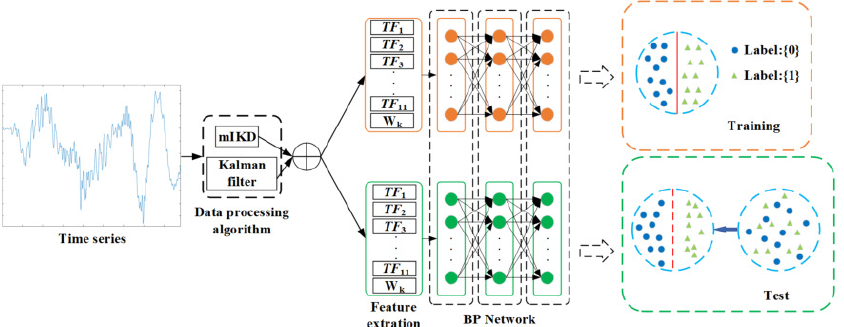
Figure 7. Prediction model of defecation based on BP neural network and bowel sound